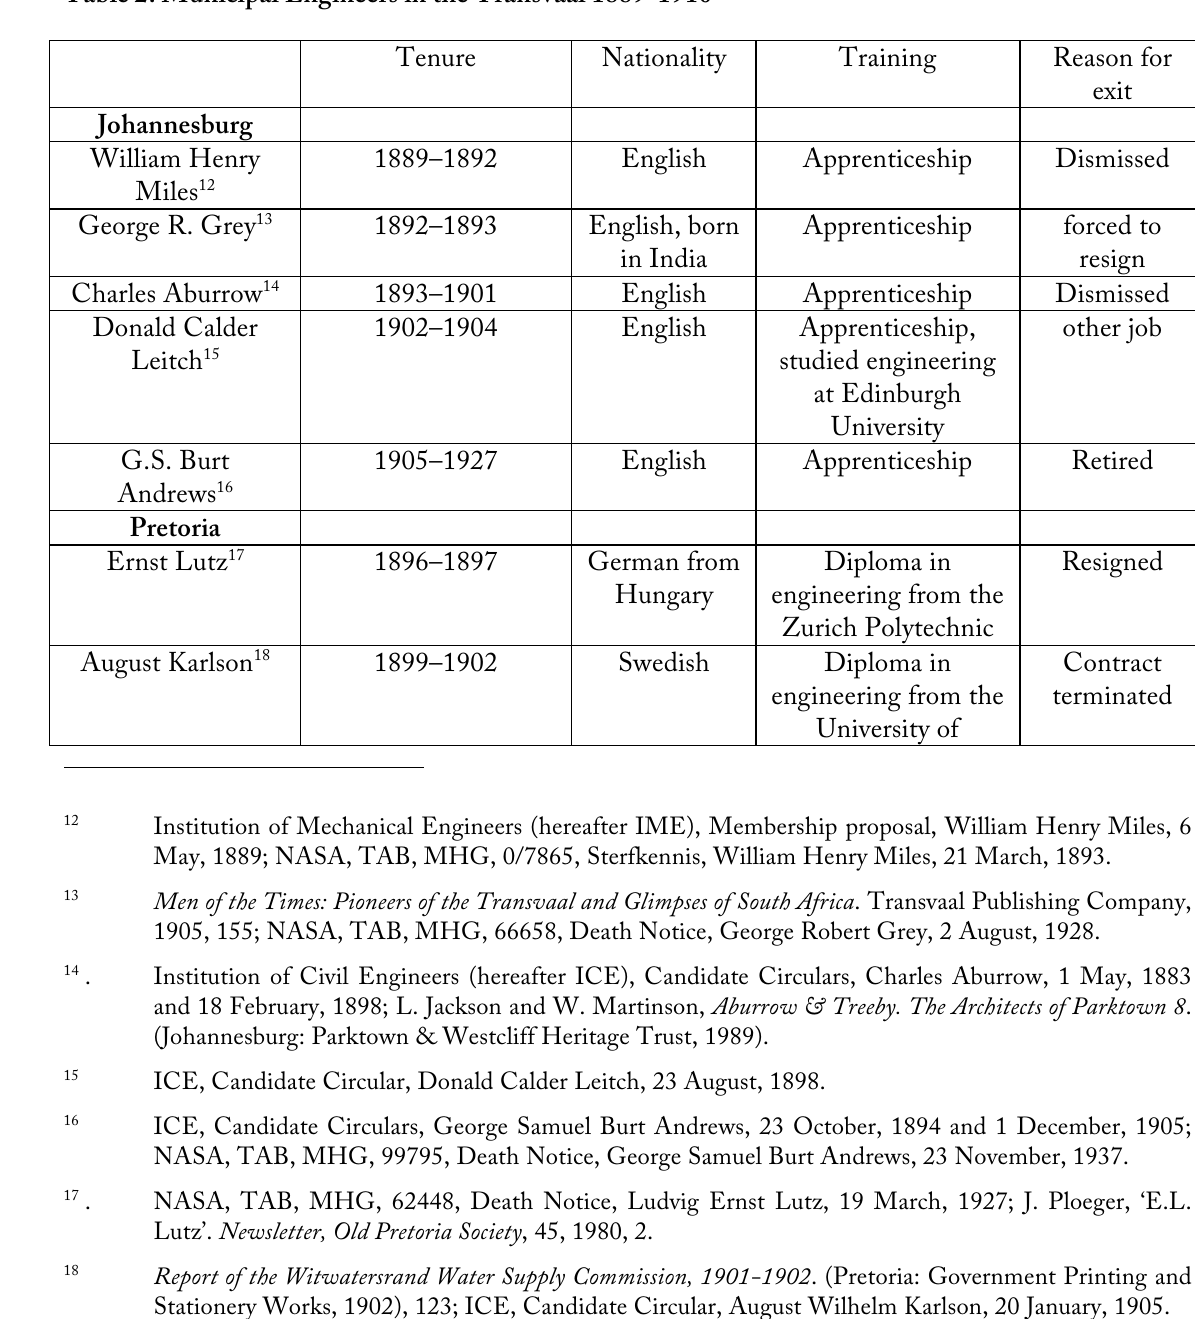
Table 2. Municipal Engineers in the Transvaal